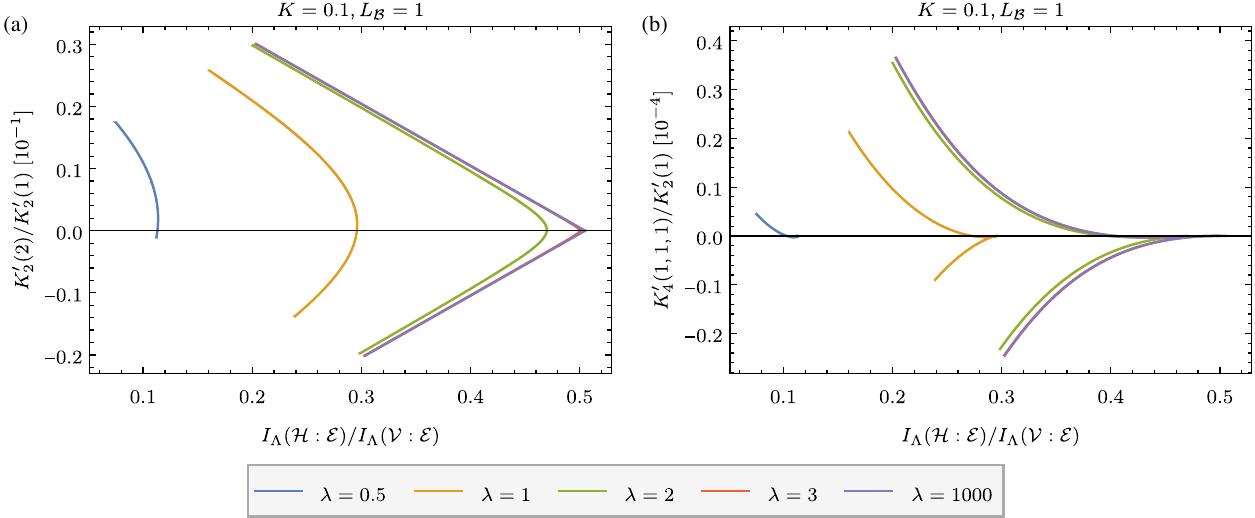
FIG. 5. The two proxy measures of complexity of the renormalized Hamiltonian discussed in the text are shown against mutual information retained: the rangeness, i.e., the ratio of the NNN to the NN coupling constants, and the m -bodyness, i.e., the ratio of the NN four-point to two-point coupling constants. The mutual information is scaled to the total mutual information the block V shares with the environment. The curves are obtained by parametrizing the RG rule as λ ½ cos ð θ Þ ; sin ð θ Þ(cid:2) and varying θ ∈ ½ 0 ; π (cid:2) for different magnitudes of λ . In the physically relevant limit of large λ , the maximum of mutual information corresponds to a minimum of rangeness and m -bodyness. The plots are discussed in more detail in Appendix D RSMI algorithm of Ref. [28] as the Λ parameters are iteratively optimized during the training (see Fig. 1).